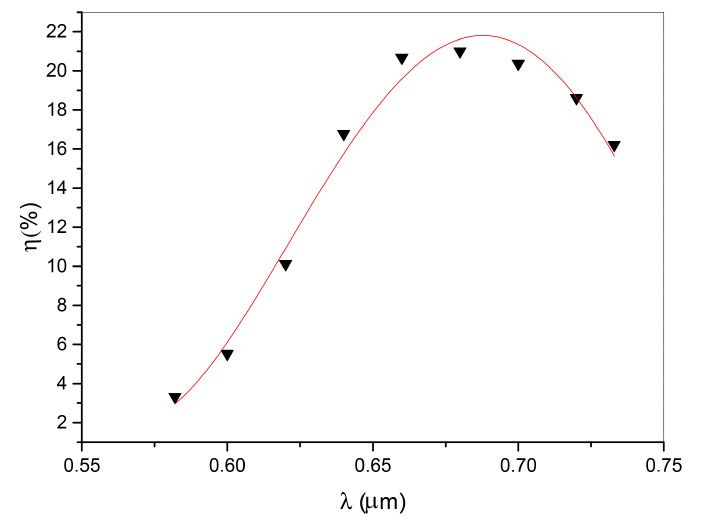
Figure 2. Maximum diffraction efficiency η as a function of wavelength. The continuous line represents the theoretical data fit obtained by using Equation